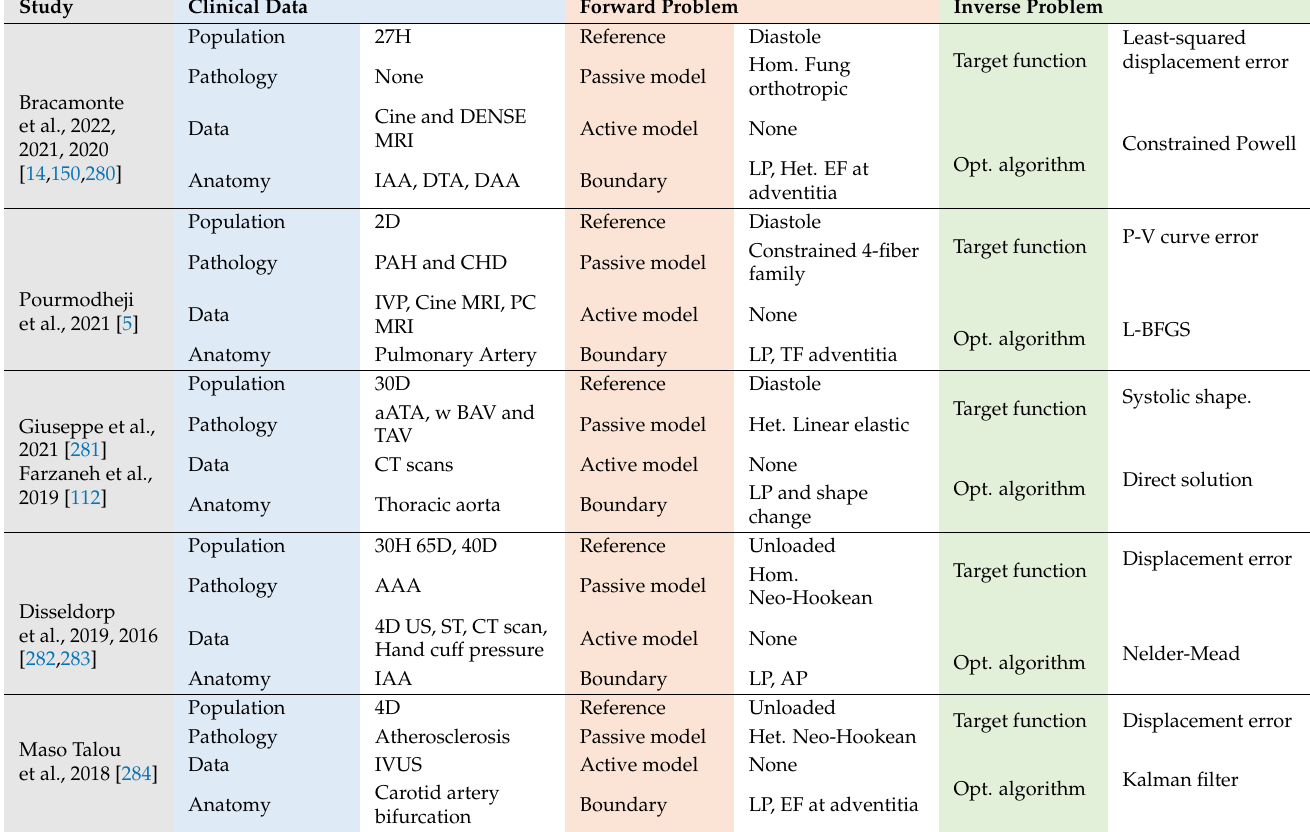
Table 8. Literature review of iterative inverse models for the analysis of human arterial wall